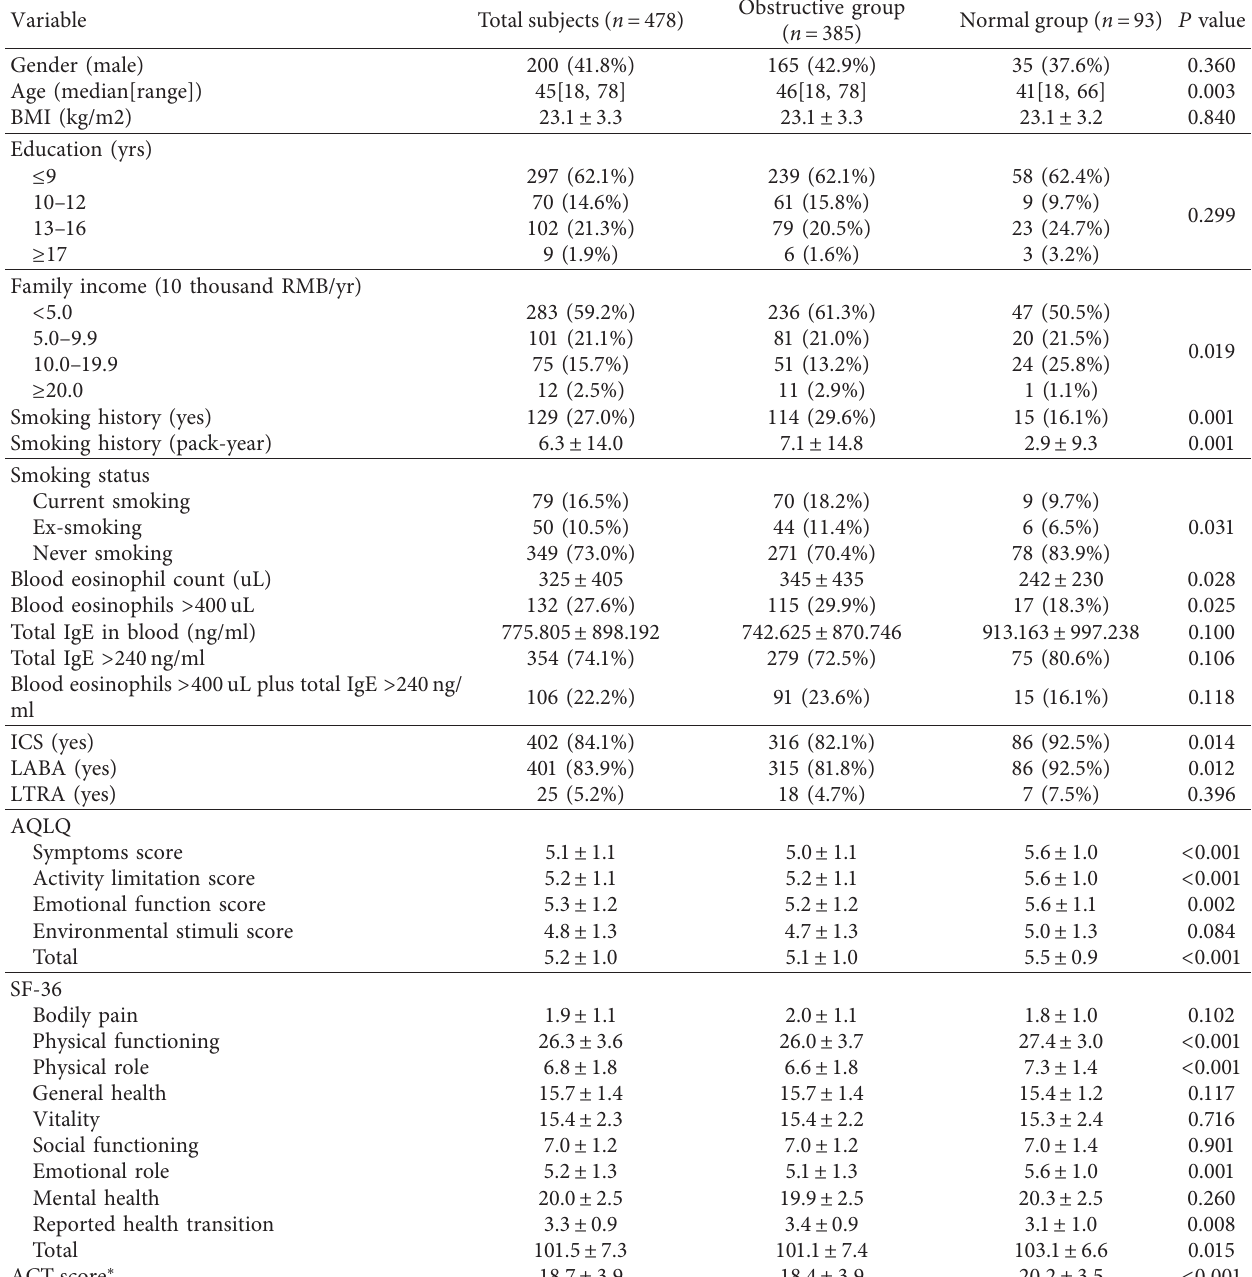
Table 1: Baseline characteristics of